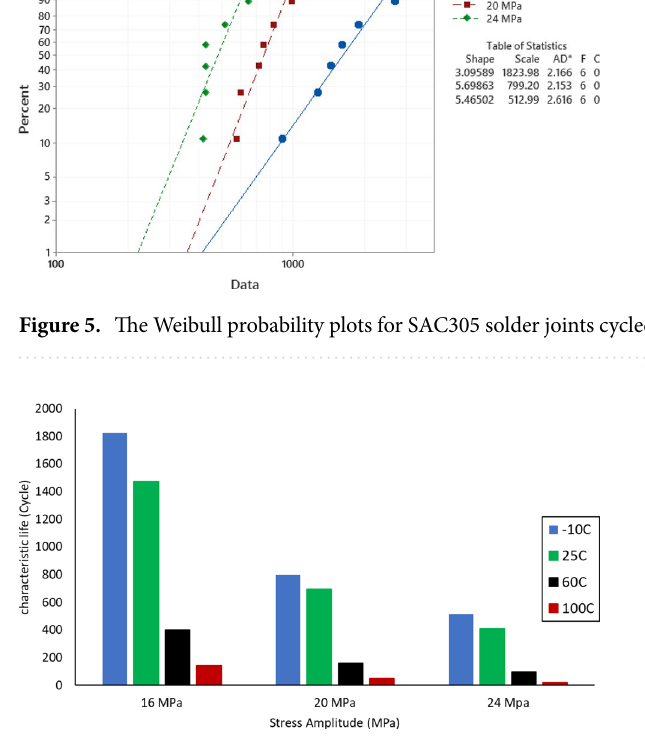
Figure 6. Bar chart for the degradations in the characteristic life when the stress amplitude or the testing temperature are